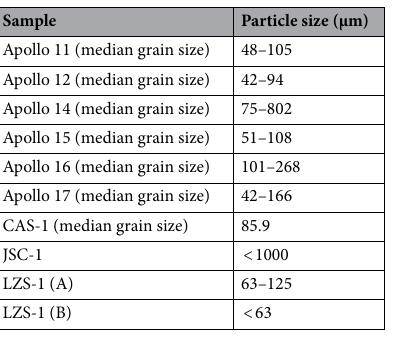
Table 1. Mean and median values of particle sizes of lunar regolith at Apollo 11–17 landing sites and the regolith simulants CAS-1, JSC-1 5 , and LZS-1.